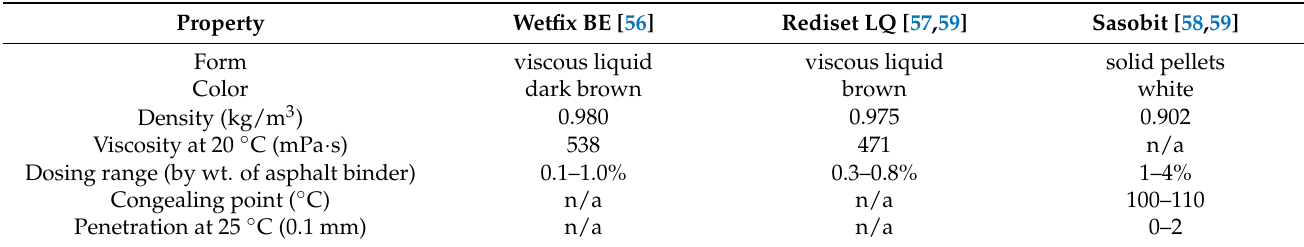
Dosing range (by wt. of asphalt